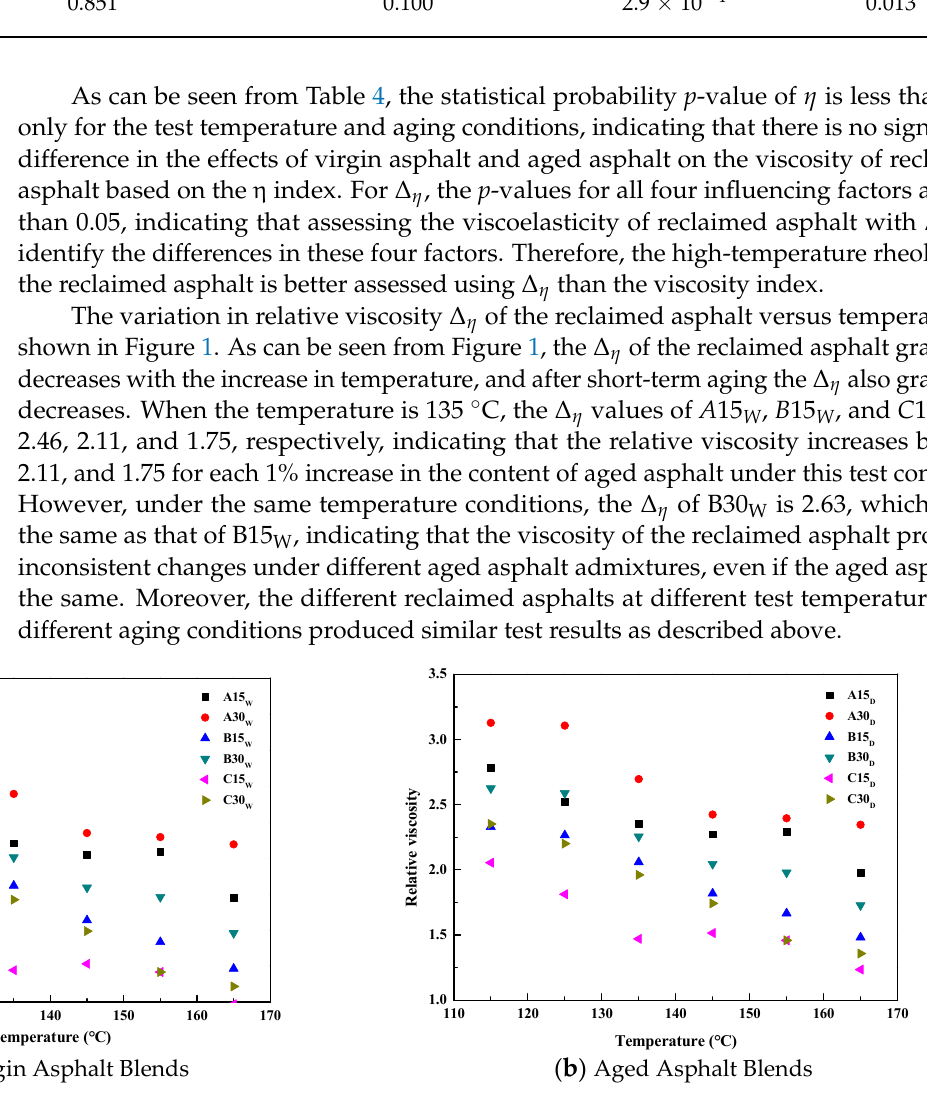
Figure 1. The results for the relative viscosity Δ η versus temperature. The regression analysis results show that the reclaimed asphalt Δ η has a good linear relationship with the test temperature (T). The regression equations are all Δ η = a T + b (a and b are the fitting parameters), as shown in Equations (2) and (3).